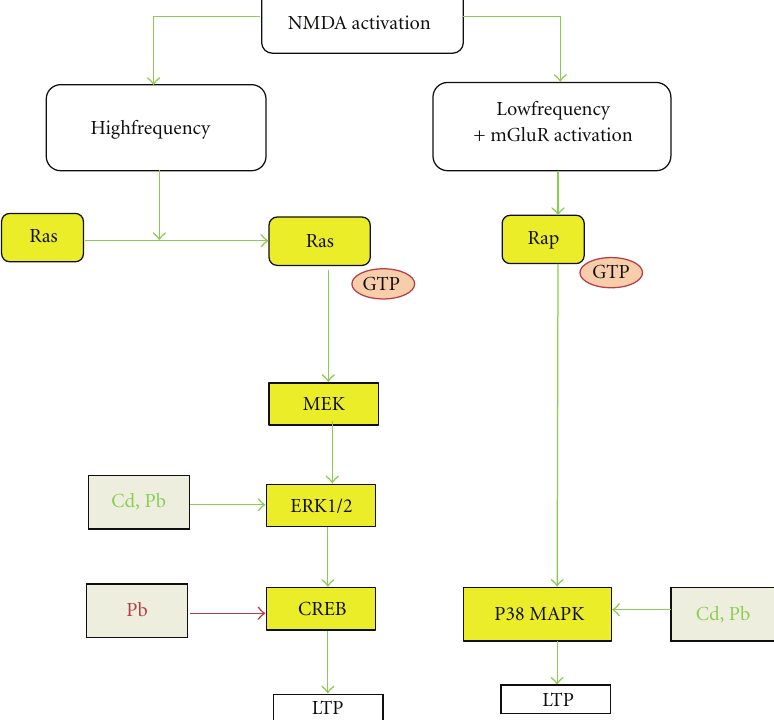
Figure 6: Molecules involved in the transcriptional control of LTP and LTD and e ff ects of metals. LTP-3 depends on the activation of ERK1/2 and CaM kinase IV, which in turn phosphorylate CREB, and this leads to new protein synthesis. Other factors such as p38 mitogen-activated protein kinase (p38 MAPK) are involved in the formation of long-term depression (LTD) and c-JUN-N-terminal kinase (JNK) is thought to participate in LTD. A green color indicates an activation or an increase, and a red color indicates an inhibition or a